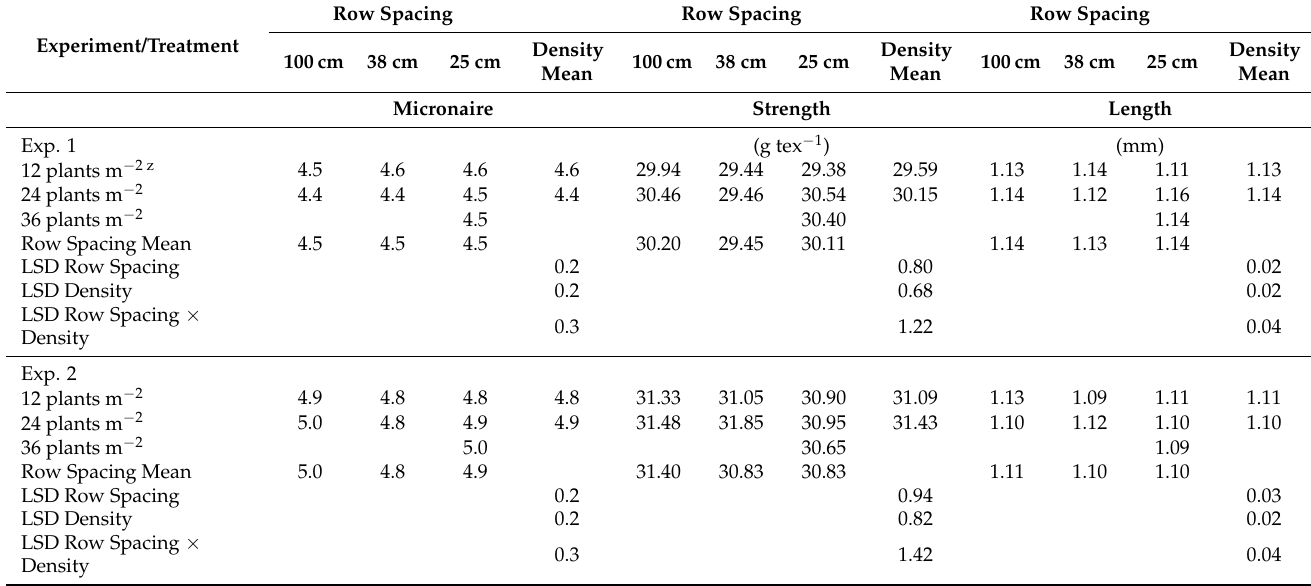
Table 6. Fiber quality for experiments comparing inter and intra row plant density (Exps. 1 and 2). LSDs are presented for comparison between plant densities, row spacing and the interaction between row spacing and plant